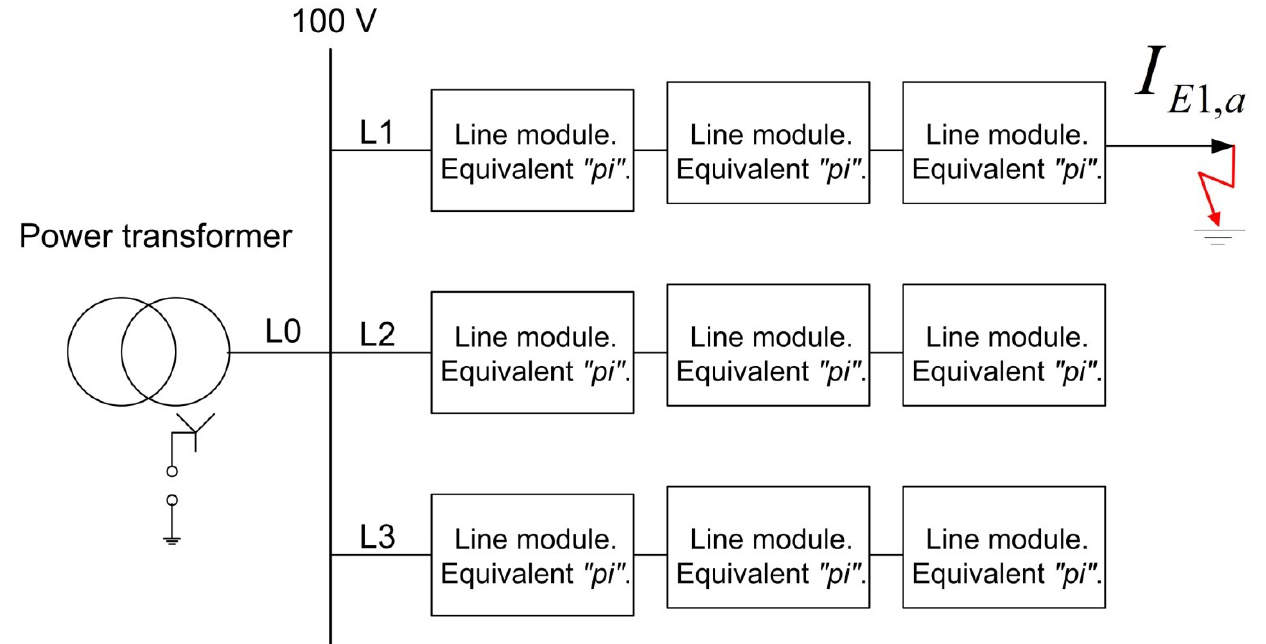
Figure 17. Single line diagram with three lines with equal length. SPGF at phase “ a ”—Line 1. Table 6. Experimental results. Three lines not loaded with identical length. Residual